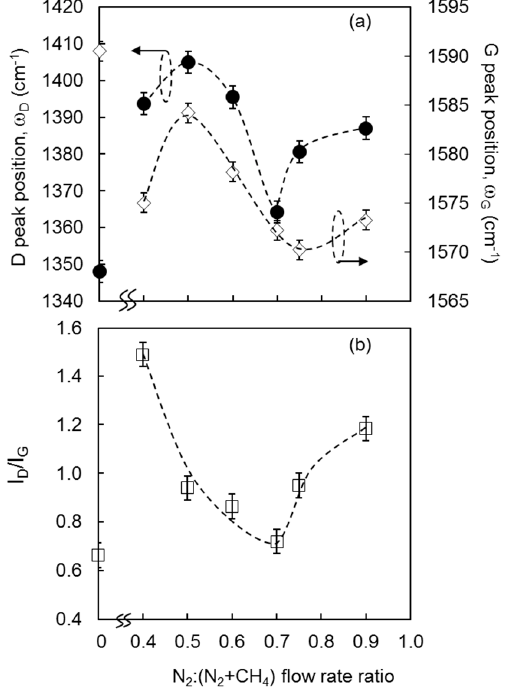
Figure 6. The variation of ω D ( ● ) and ω G ( ◊ ) ( a ); and I D /I G ( □ ) ( b ) as a function of N 2 :(N 2 + CH 4 ) flow rate ratio.